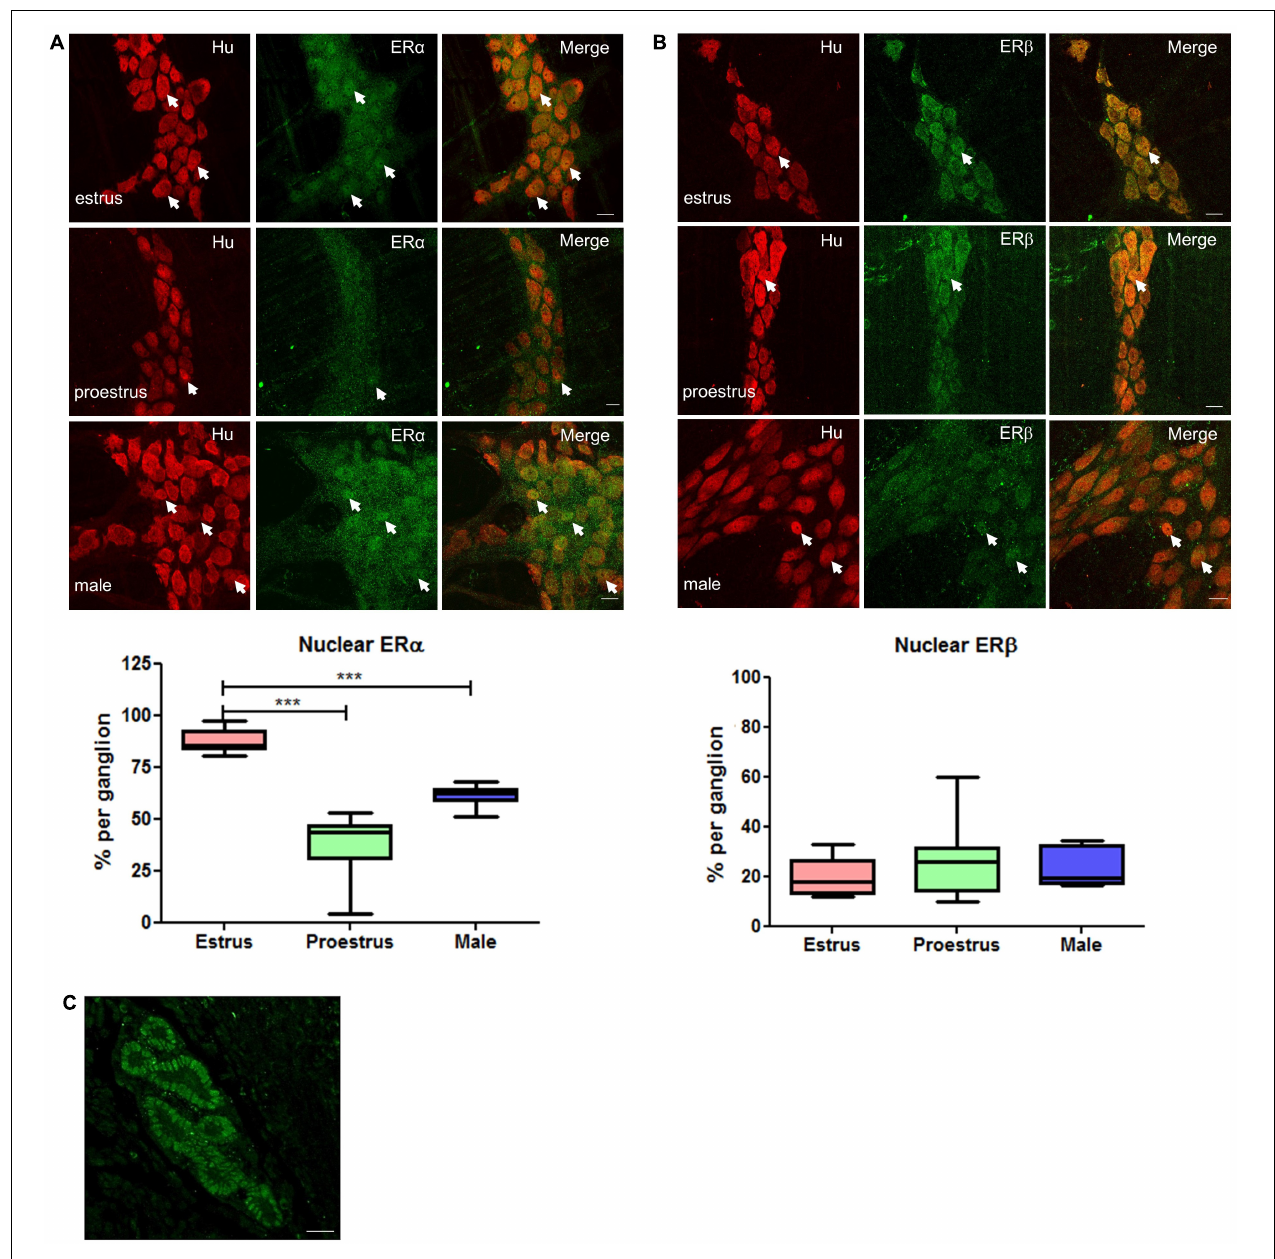
FIGURE 3 | Whole mount preparations of myenteric plexus expressing pan neuronal marker Hu in red and ER α /ER β in green. Significantly higher numbers of myenteric neurons expressed ER α in the nucleus during estrus while having some cytoplasmic expression compared to proestrus females and male myenteric neurons expressing less nuclear and cytoplasmic ER α . ER β expression was more cytoplasmic in all tissue samples and showed no significant difference in expression between groups. Scale bar = 20 µ m ( n = 3, One-way ANOVA, *** p < 0.001). (A) Localization of ER α in the myenteric plexus preparations of estrus, proestrus, and male colon: ER α labeling was observed in more than 90% of myenteric neurons in both male and female mice. Images of representative myenteric ganglia, demonstrating neurons stained for Hu, ER α , and merged images of both Hu and ER α . During estrus stage, ER α labeling is predominantly nuclear while during proestrus and in male mice both nuclear and cytoplasmic labeling was observed (arrows indicate nuclear labeling of ER α ). Scale bars = 20 µ m. Graph shows quantified data ( n = 3) where there was significantly higher nuclear localization observed during estrus stage compared to both proestrus and male preparations (*** p < 0.001). (B) Localization of ER β in the myenteric plexus preparations of estrus, proestrus, and male colon: localization of the estrogen receptor beta (ER β ) is unchanged during estrus. ER β labeling was observed in more than 90% of myenteric neurons in both male and female mice. Images of representative myenteric ganglia, demonstrating neurons stained for Hu, ER α , and merged images of Hu and ER α . No significant difference was observed among the groups with respect to nuclear labeling of ER β (arrows indicate nuclear labeling of ER β ). Scale bars = 20 µ m. The graph shows quantified data ( n = 3) where there was no significant difference among the groups ( p > 0.05). (C) Specificity of ER α PA1-308-antiserum was tested in a uterine tissue. Labeling was observed in the glandular epithelial cells of the uterus (frozen cross section). Scale bar = 20 µ